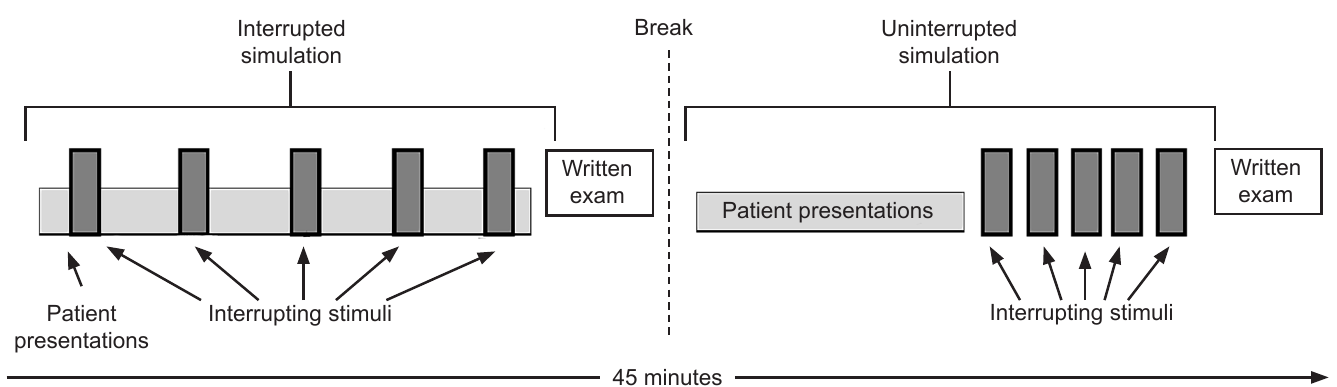
Figure 1. Participant flow through the crossover simulation trial evaluating accuracy of screening electrocardiogram interpretation for ST- elevation myocardial infarction. Participants first completed the task-switching simulation, viewing patient presentations interrupted by clinical stimuli. Then, after completing a written exam and a short break, participants completed the uninterrupted simulation, viewing patient presentations and interpreting clinical stimuli independently and